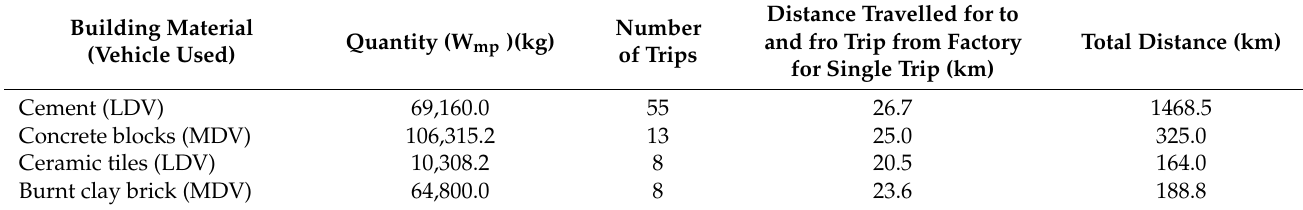
Table 3. Total distance travelled by the transportation vehicle with materials.